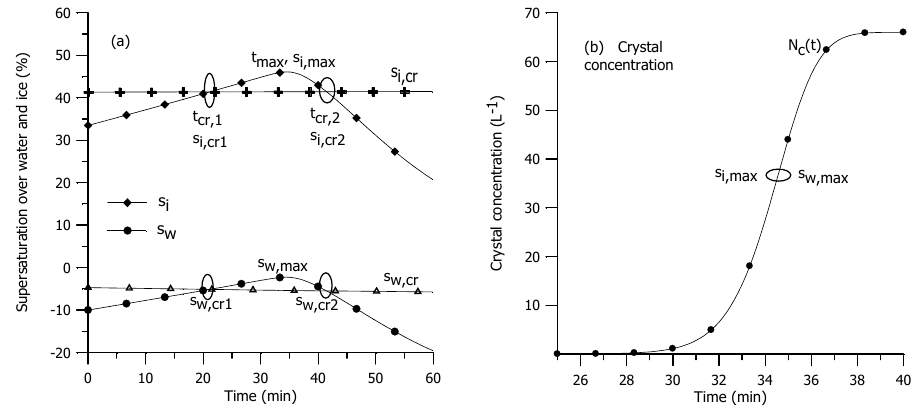
Fig. 7. General features of homogeneous ice nucleation kinetics (evolution of water and ice supersaturations and crystal concentration) illustrated with a parcel model run with the parameters: initial temperature T c = − 40 ◦ C, s w (t = 0) = − 0.1 ( − 10%), lognormal size spectrum of haze particles with mean geometric radius of 0.02µm and concentration N a = 200cm − 3 . The symbols t cr , 1 and t cr , 2 (marked with ellipses) denote the 1st and 2nd times when critical (threshold) ice supersaturations s i , cr1 and s i , cr2 are reached, that is, the start and end of nucleation; t max is the time when maximum ice and water supersaturations s i , max , s w , max are reached; s w , cr denote the curves of critical (threshold) water and ice